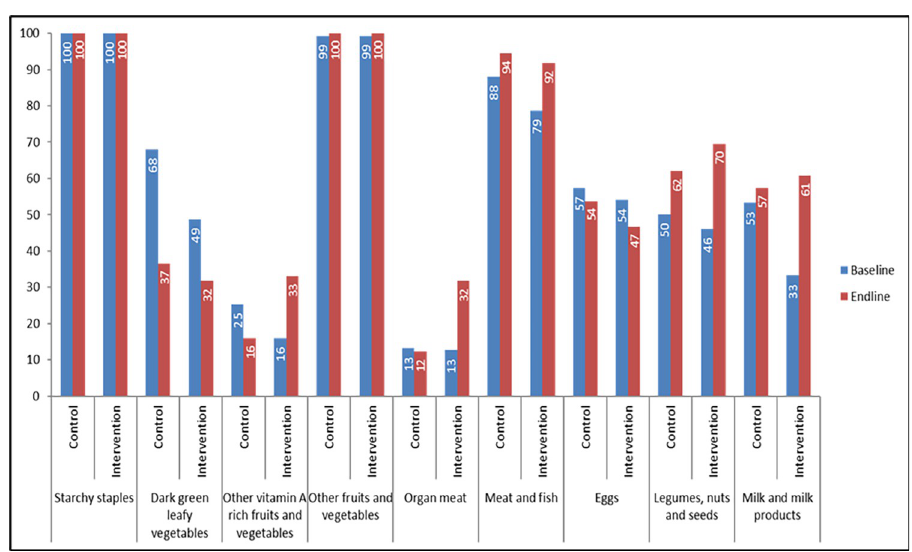
Fig 2. Dietary diversity (food groupwise) among the adolescent girls.